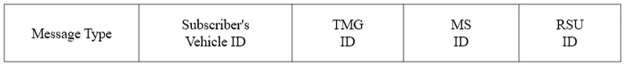
Portion of the JTMG packet.